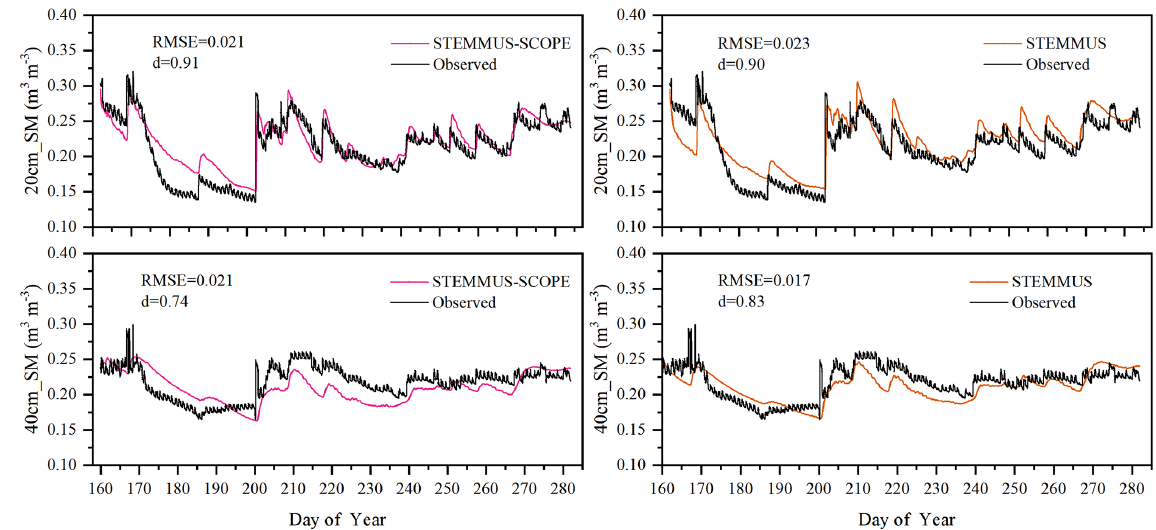
Figure 3. Comparison of modeled and observed soil moisture at 20 (20cm_SM) and 40cm (40cm_SM) depth for the maize cropland at Yangling station.